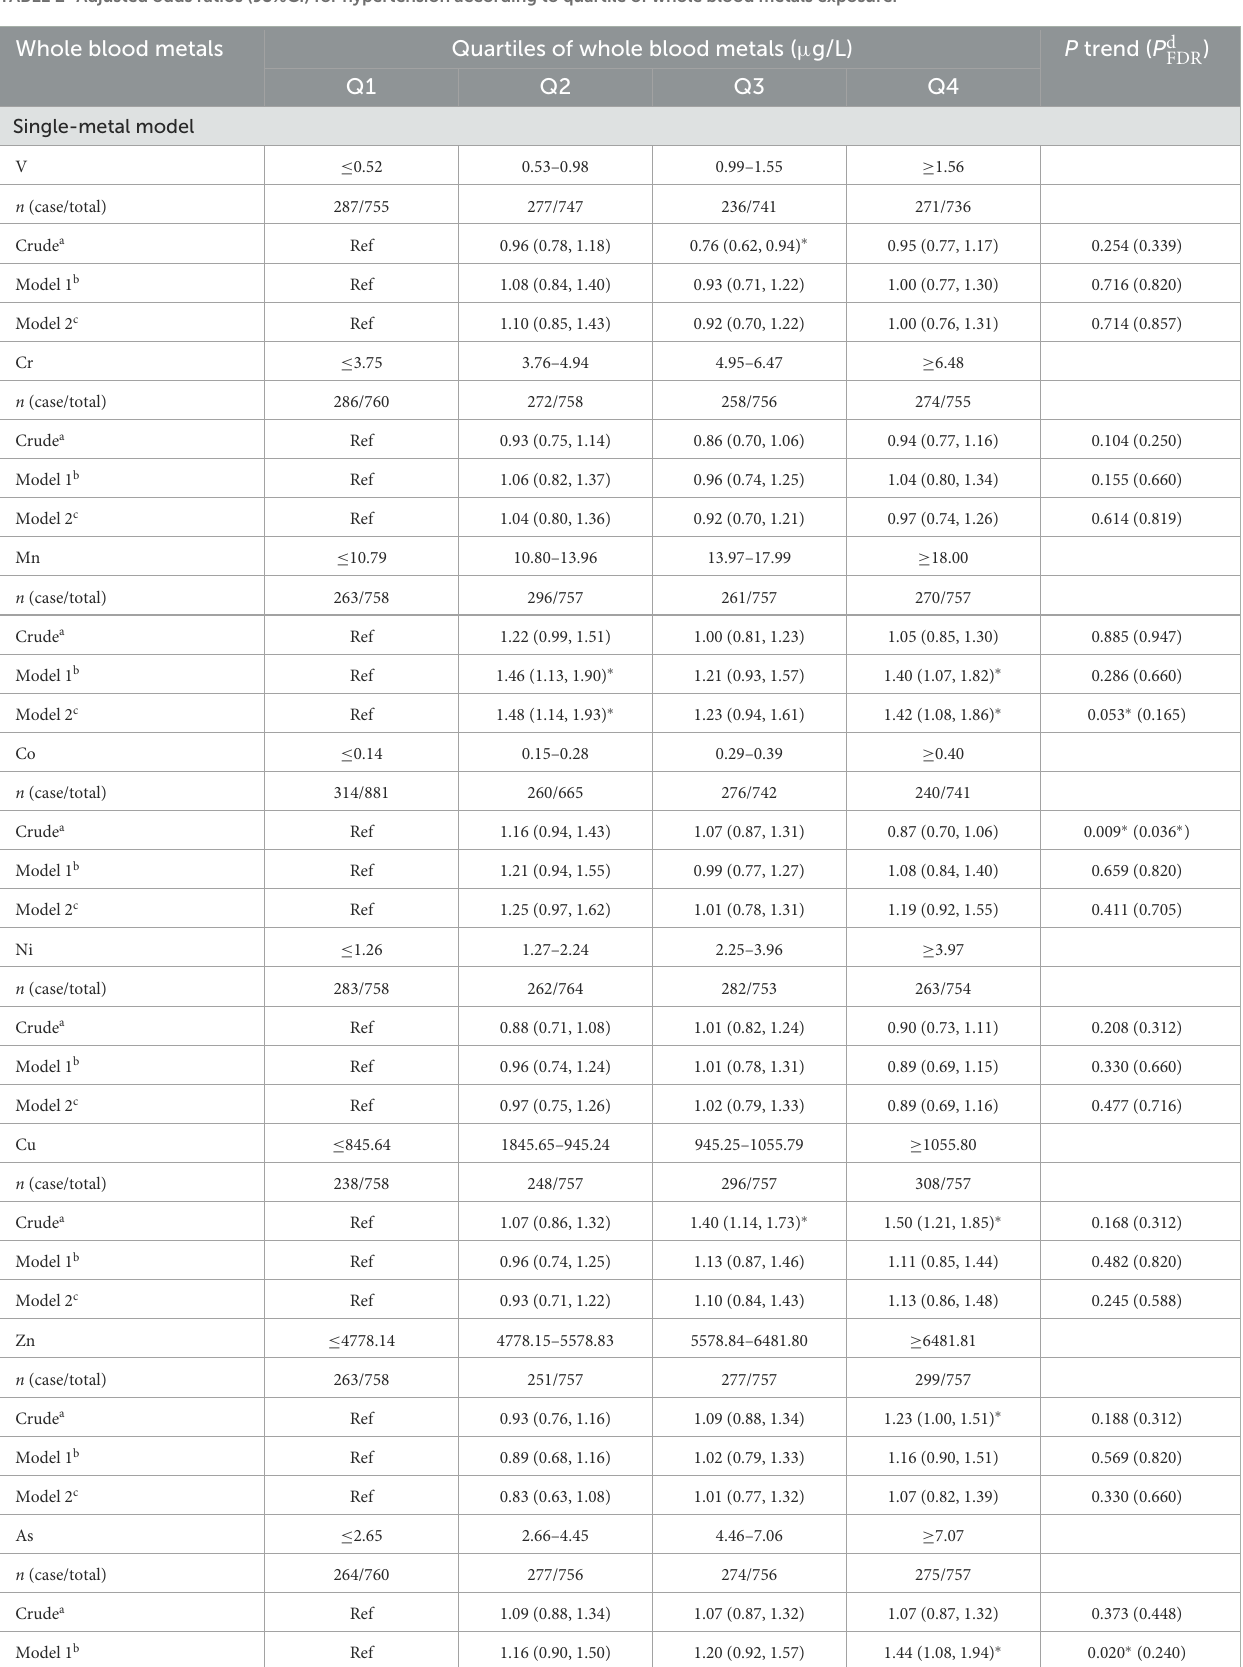
TABLE 2 Adjusted odds ratios (95%CI) for hypertension according to quartile of whole blood metals